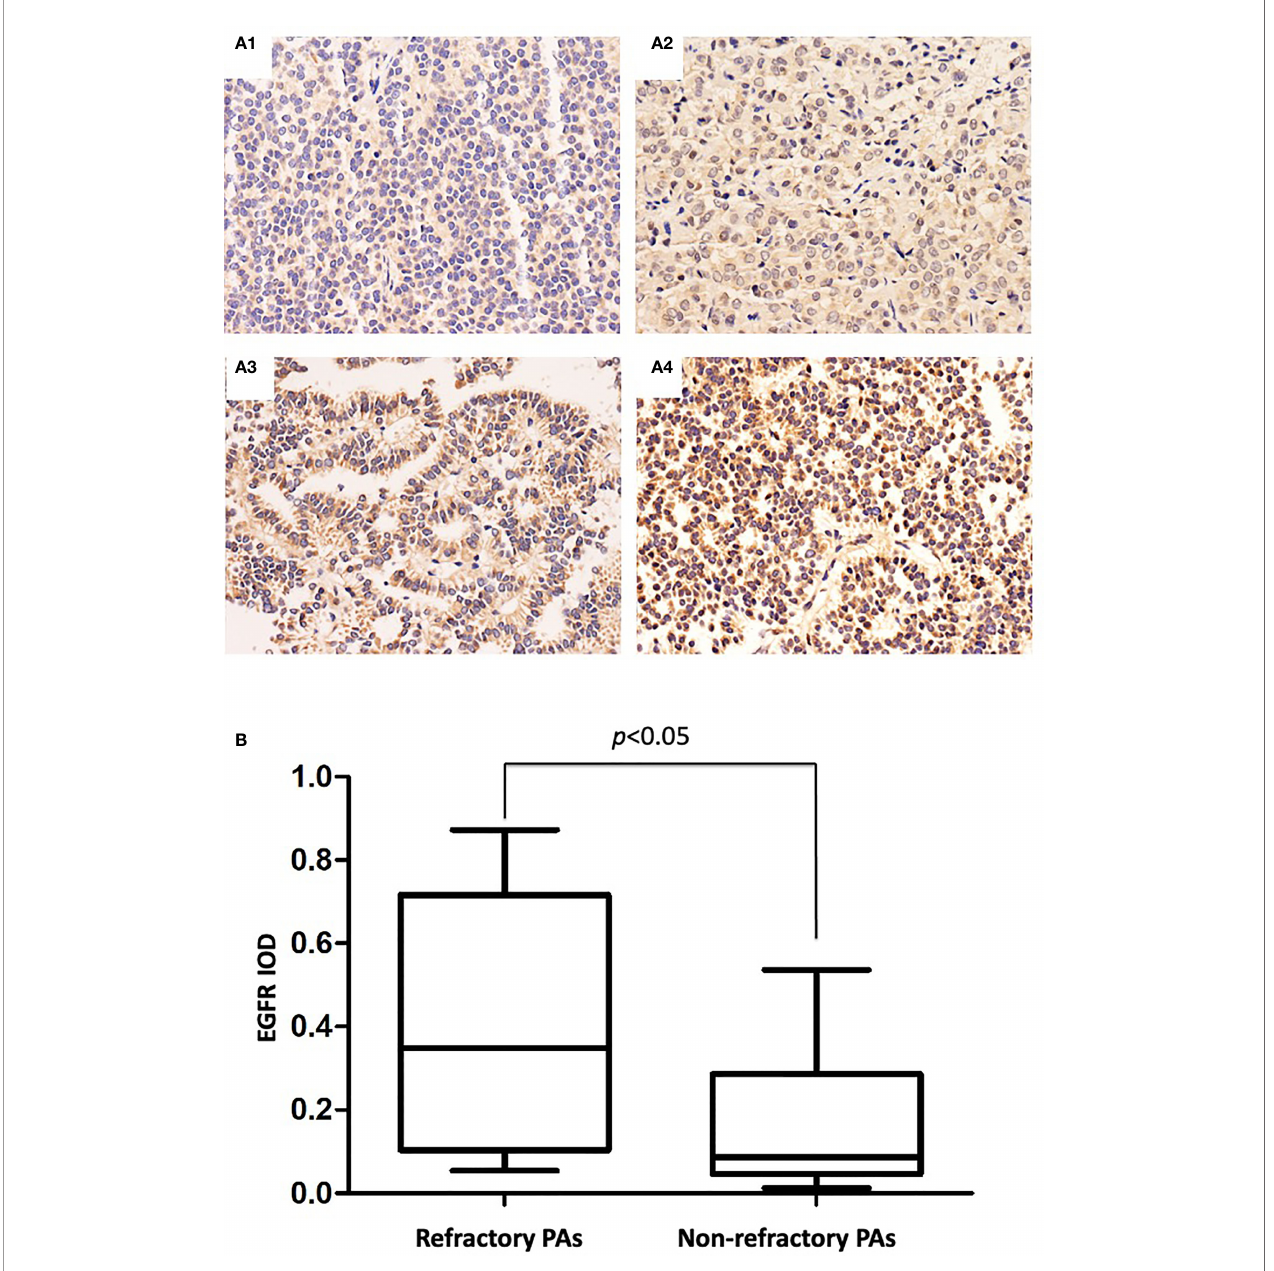
FIGURE 3 | (A) Immunohistochemical staining of EGFR in PAs. (A1) IOD: 0.036 (×100 magni fi cation). (A2) IOD: 0.192 (×100 magni fi cation). (A3) IOD: 0.466 (×100 magni fi cation). (A4) IOD: 0.842 (×100 magni fi cation). (B) , EGFR mean IODs of refractory PAs and nonrefractory PAs. The mean EGFR IOD of the refractory PAs was signi fi cantly increased compared with that of the nonrefractory PAs (0.381 vs. 0.114, p <